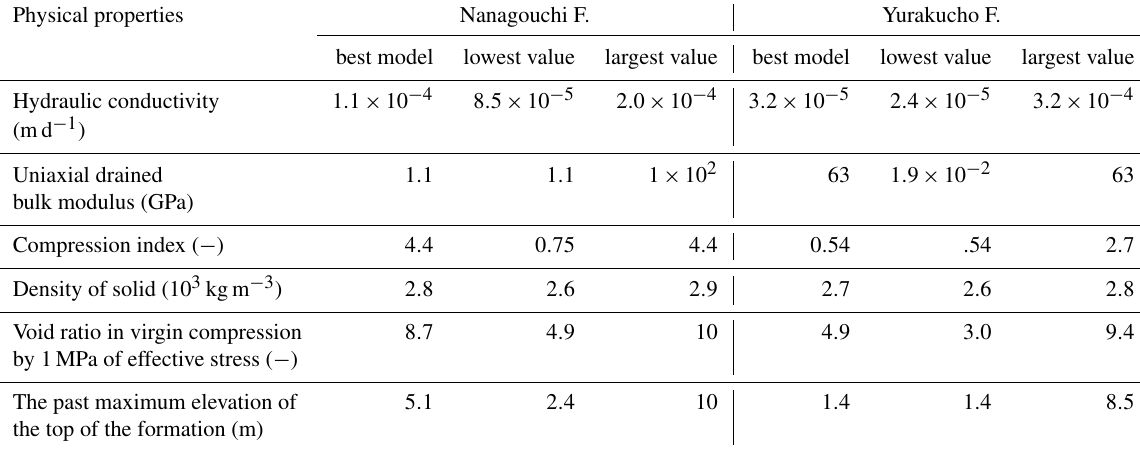
Table 2. Parameter range of best 5 models after the calibration. Physical